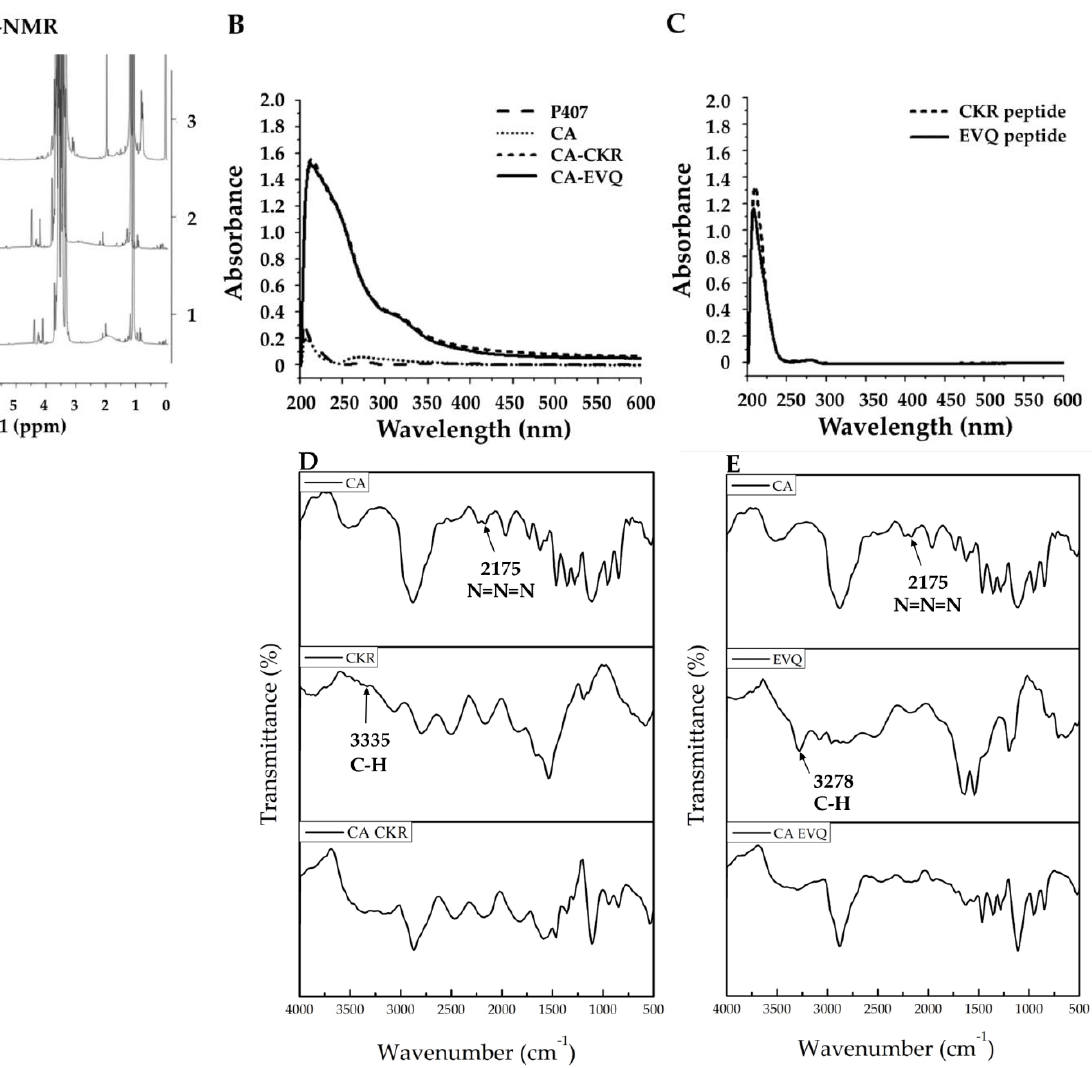
Figure 7. Characterization of cargo azide (CA). ( A ) 1 H-NMR and ( B ) 13 C-NMR spectrum of P407- 653 OH, P407-CHO, and CA.